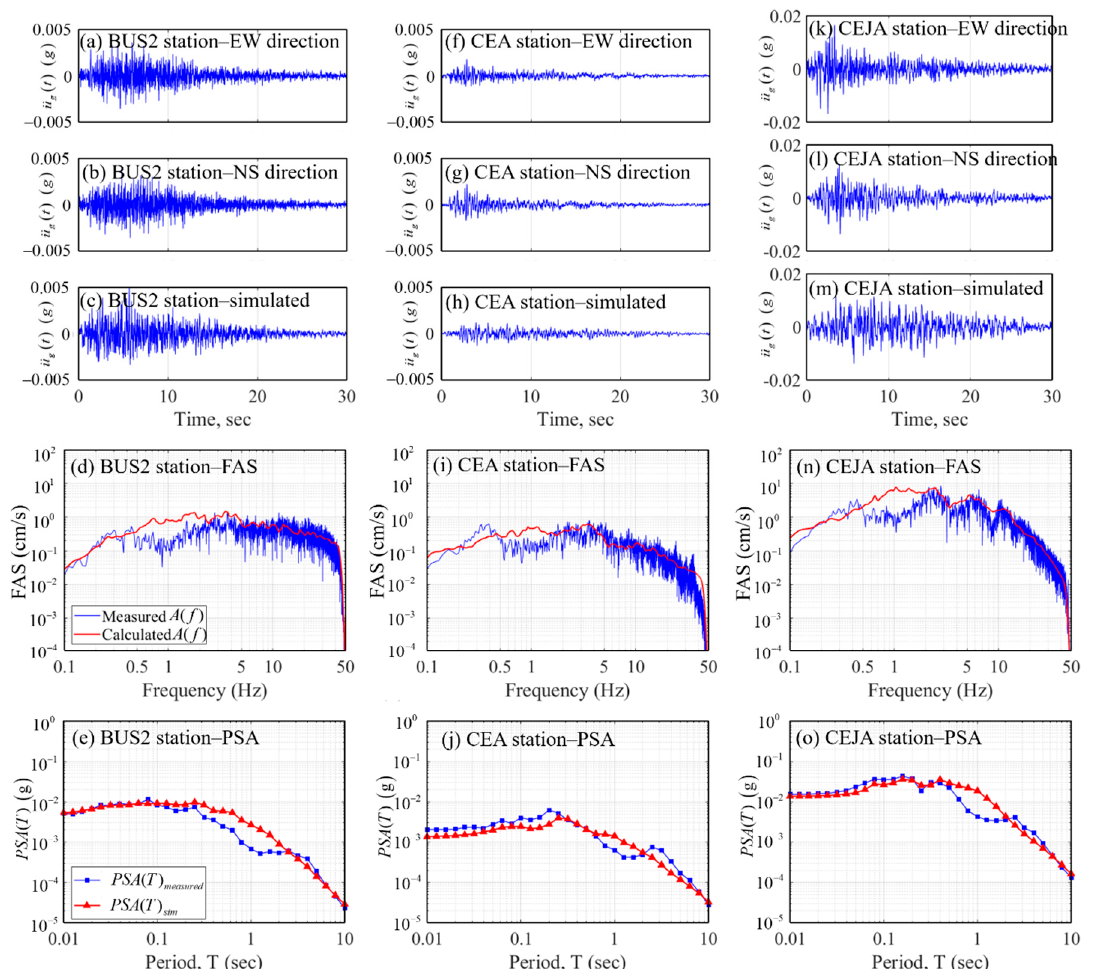
Figure 12. Recorded and simulated ground motion at sample stations: (a) BUS2 station-EW direction, (b) BUS2 station-NS direction, (c) BUS2 station-simulated, (d) BUS2 station-FAS, (e) BUS2 station-PSA, (f) CEA station-EW direction, (g) CEA station-NS direction, (h) CEA station-simulated, (i) CEA station-FAS, (j) CEA station-PSA, (k) CEJA station-EW direction, (l) CEJA station-NS direction, (m) CEJA station-simulated, (n) CEJA station-FAS, (o) CEJA station-PSA.